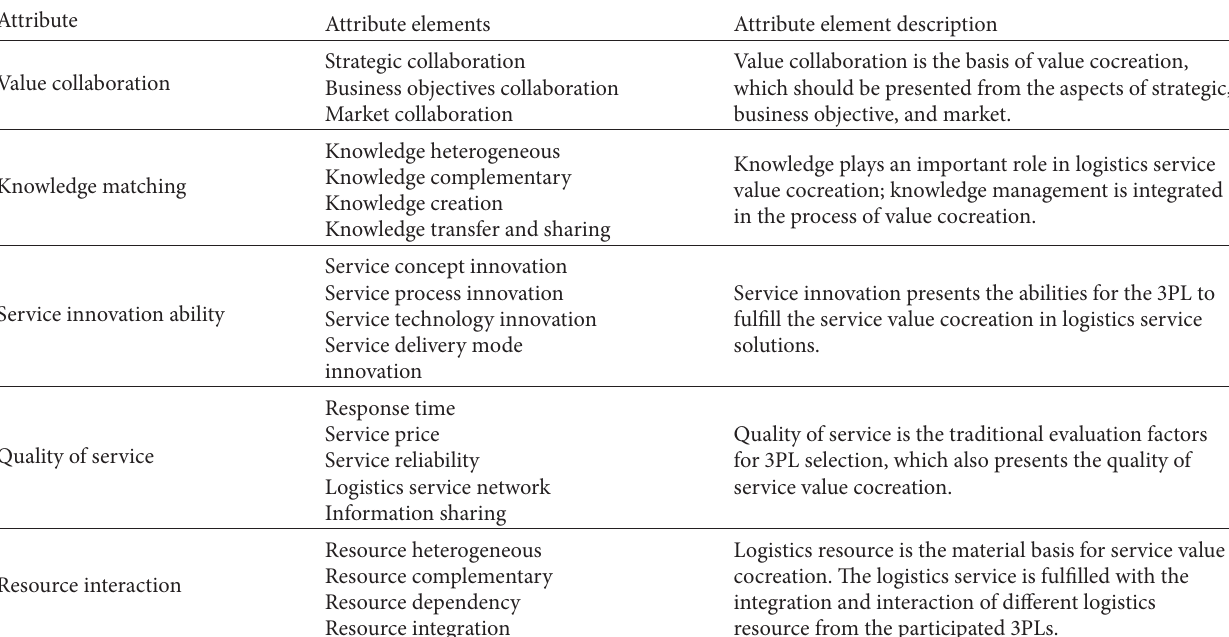
Table 1: The attributes of supplier selection in logistics service value